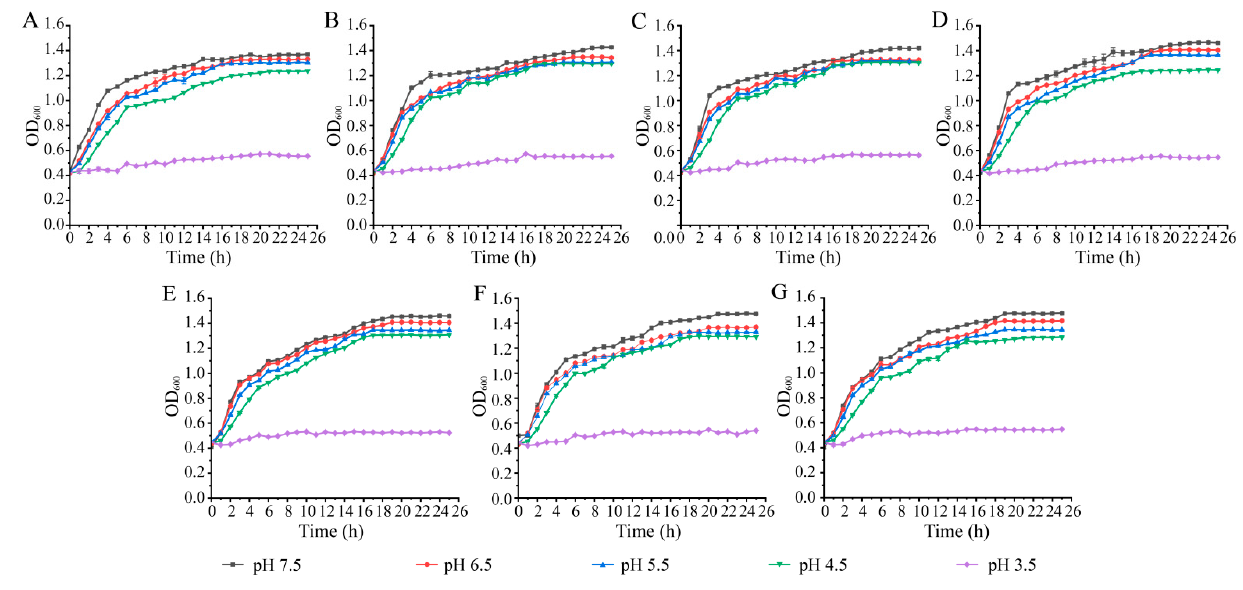
Figure 1. Growth of the K. pneumoniae isolates under different pH conditions. The isolates were incubated in the TSB (0.5% NaCl) at 37 °C. ( A – G ): K. pneumoniae 7-5-4, 7-10-14, 7-13-2, 7-17-8, 8-1-12-1, 8-2-5-4, and 8-2-10-5, respectively.